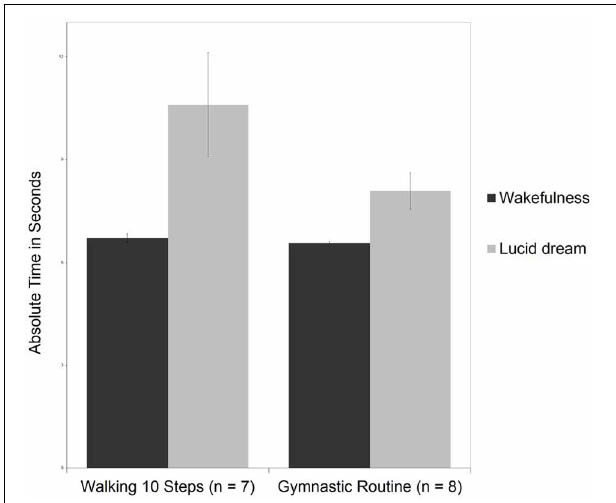
FIGURE 8 | Means and standard deviations for walking 10 steps and the gymnastic routine during wakefulness and lucid dreaming.